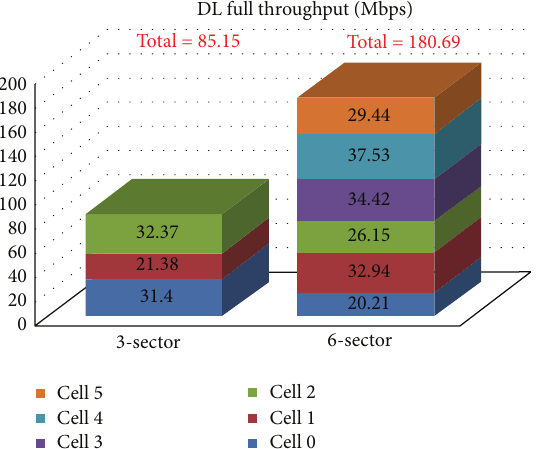
Figure 6: The cell full downlink throughput in Mbps before and after the 6-sector integration.